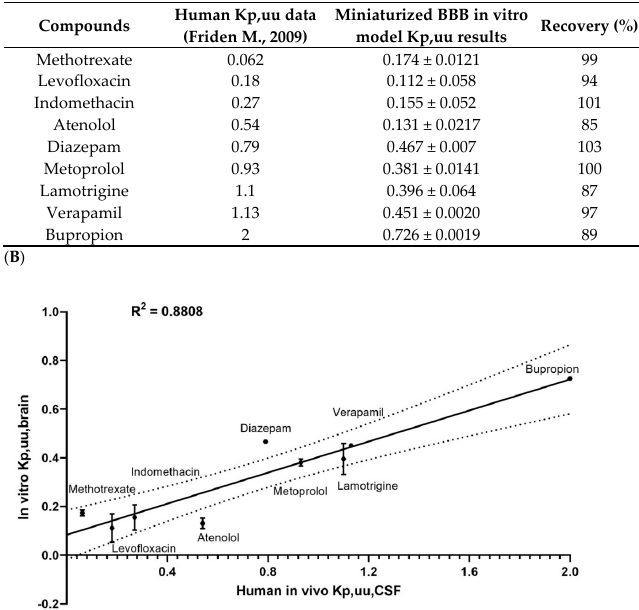
Figure 6. Screening application of the miniaturized and automated human BBB in vitro model. ( A ) Values (mean ± SD) of the unbound fraction ratio of the CSF/plasma in humans (in vivo Kp,uu,CSF) data obtained from Friden M et al. 2009. Unbound fraction ratios of the brain/plasma predicted in vitro (in vitro Kp,uu,brain) through the 96 TW miniaturized and automated human models. The concentrations were detected by mass spectrometry (LC–MS/MS system) with the calculation of the total amount of unbound molecules recovered (recovery, expressed in percentage). ( B ) Correlation between the Kp,uu,CSF and Kp,uu,brain nonlinear equations; R 2 = 0.8808; n = 3; N = 1.